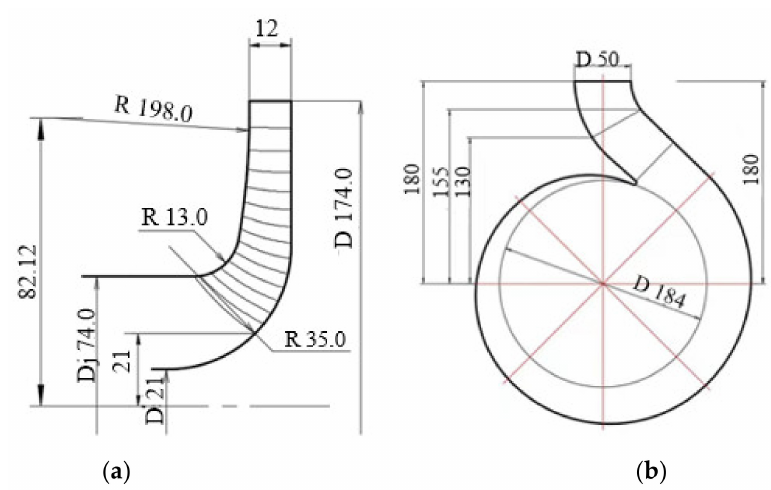
Figure 1. Sectional view of ( a ) impeller, ( b ) volute.